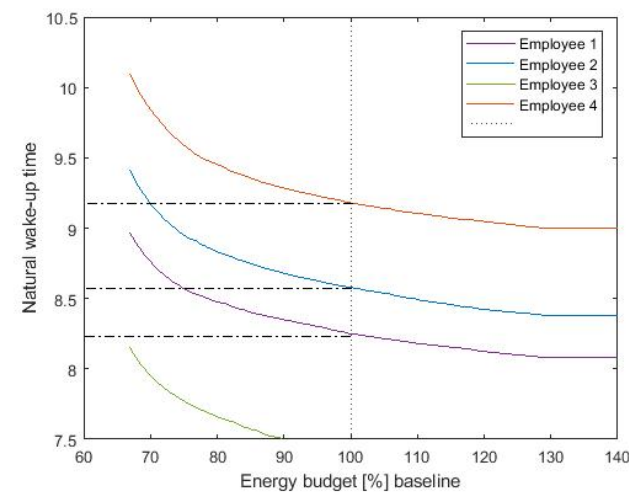
Figure 8. Resulting wake-up times as a function of the available energy budget. At 100% of the baseline energy budget, the optimization algorithm is able to shift the wake-up times of employee 2 by 12 min and employee 4 by 15 min, while employee 3 is able to reach the targeted alarm time at 90% of the baseline energy.